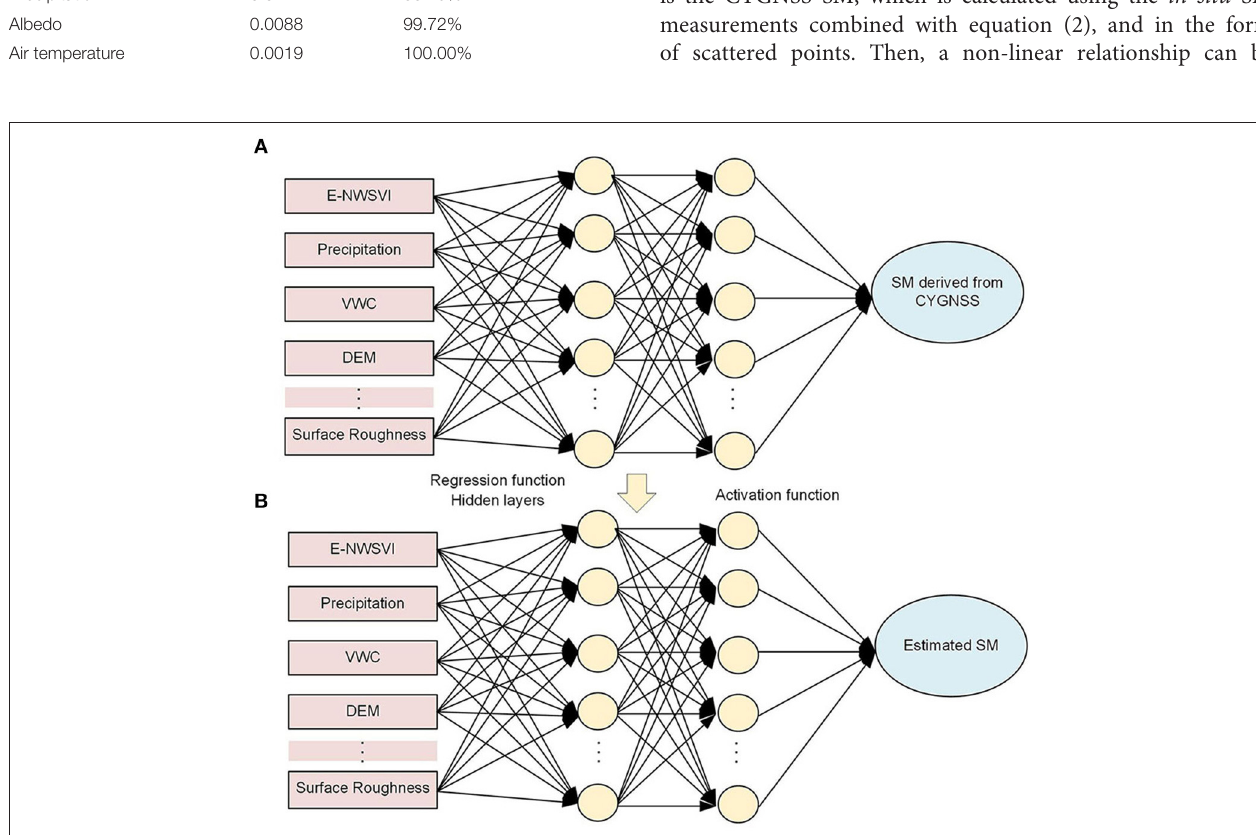
FIGURE 7 | The BP-ANN model to estimate daily SM. (A) Training. (B) Testing.